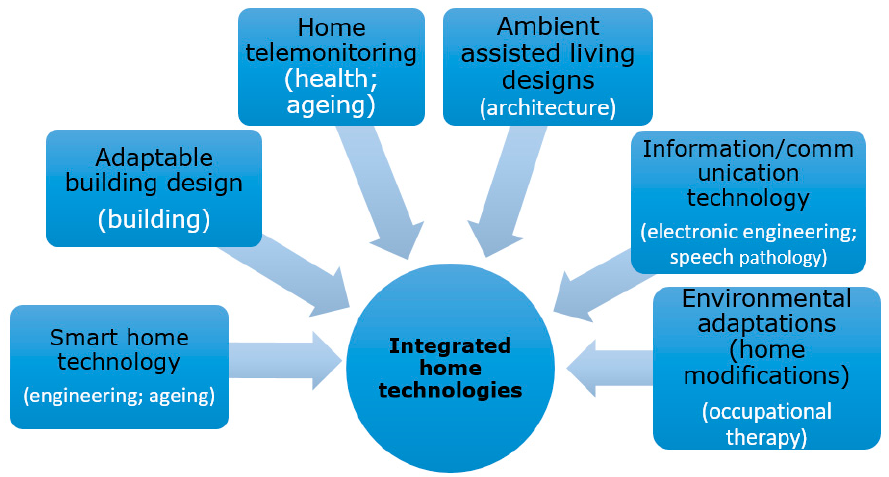
Figure 1. Disciplines and discourses related to integrated home technologies.